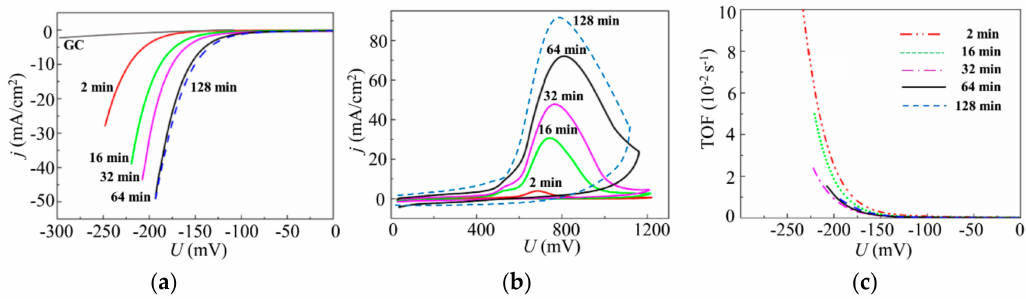
Figure 12. ( a ) Polarization curves. ( b ) Anodic cyclic voltammograms. ( c ) TOF dependence on voltage for the MoS x ~2 + δ / Mo catalysts obtained on the GC substrate by on-axis PLD in Ar at 8 Pa for di ff erent deposition times.